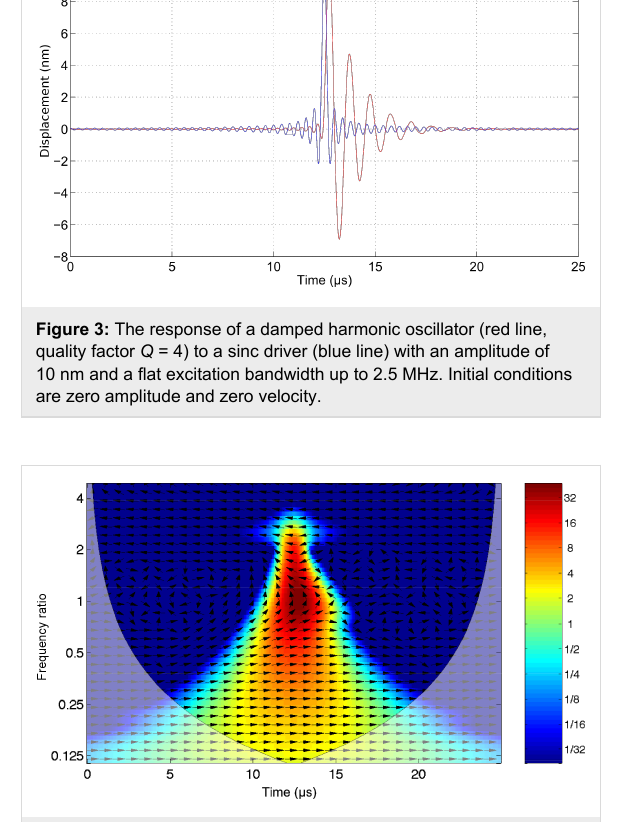
Figure 4: Wavelet cross-correlation between the sinc driver and the response of the damped harmonic oscillator (quality factor Q = 4), as shown in Figure